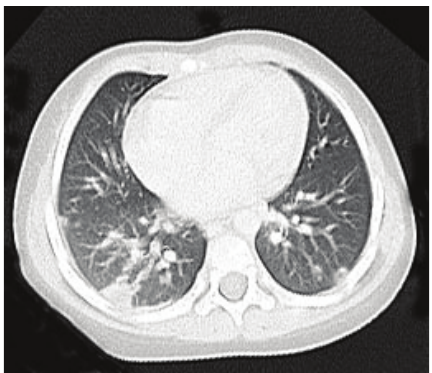
Figure 1: Computed tomography scan of the lungs without contrast showing necrotizing pneumonia with multiple nodules and pleural effusion on